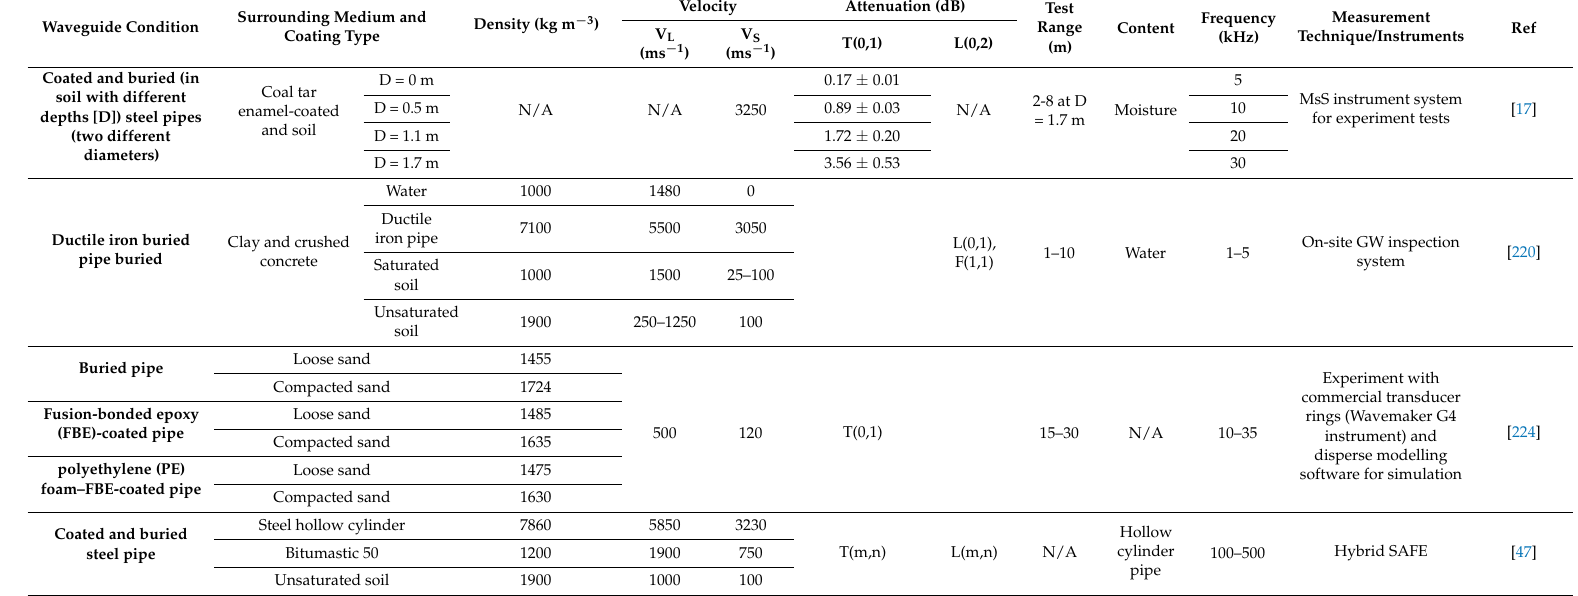
Table 5. Measured values for GWs propagation in different buried/coated pipe